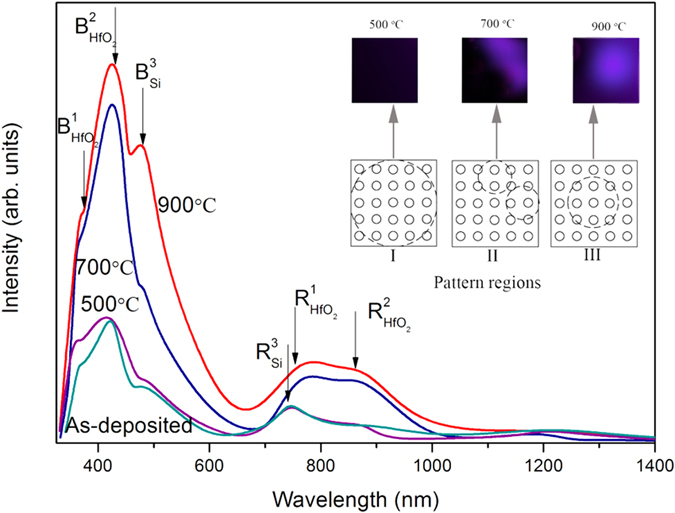
Typical PL spectra for the samples with HfO2 filled into the Si microcavities.B and R, denotes the blue subpeak and red subpeak, respectively. The top number (1, 2 and 3) is the order of subpeaks. The bottom symbol of “Si” and “HfO2” is the origination of emission. The samples were annealed in vacuum at 500, 700 and 900 °C, respectively. For comparison, the PL spectrum of as-deposited sample was also shown. Inset is the images of blue light emission for samples annealed at 500, 700 and 900 °C, respectively.